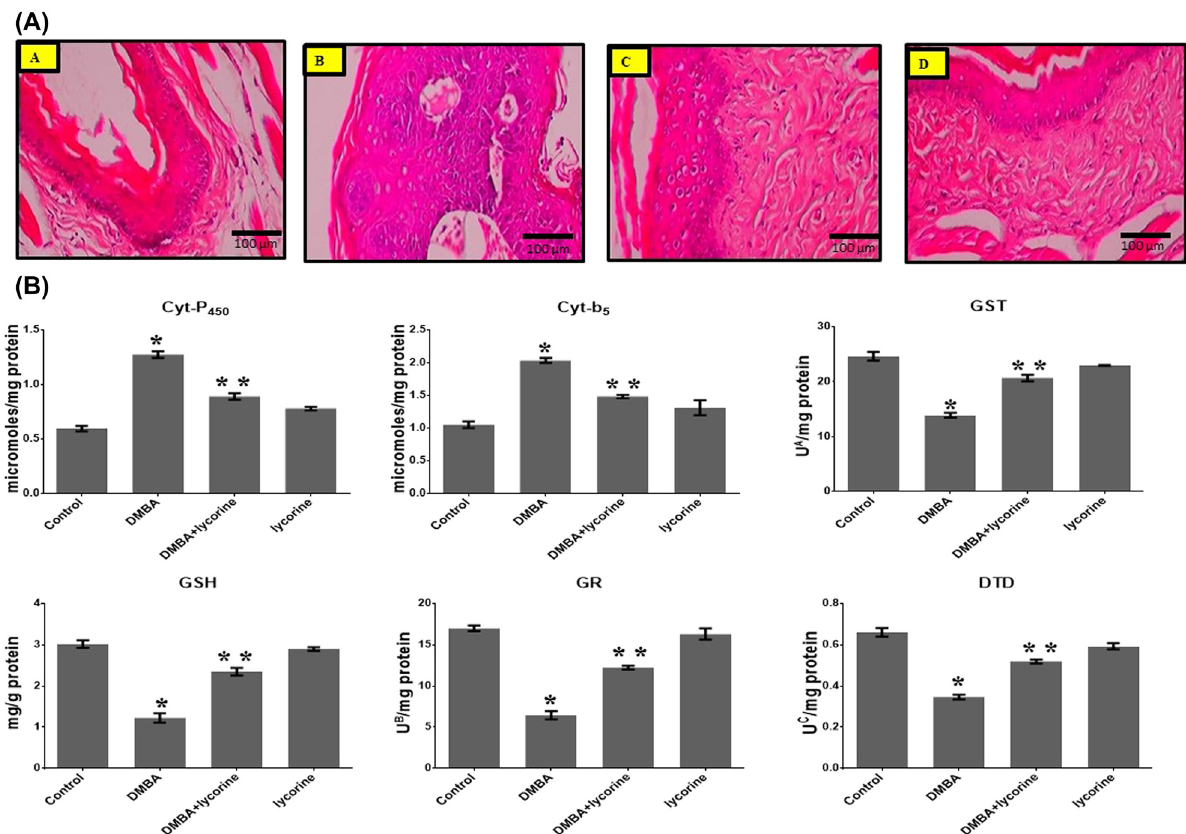
Figure 1: (A) Histopathological alterations in the buccal mucosa of all experimental hamsters. A and D images show distinct epithelium of buccal pouch in hamsters of normal control and lycorine-alone treated group. B images show well-differentiated squamous cell carcinoma DMBA alone treated animals.C images show very low or moderate dysplastic epithelium in hamsterstreated with DMBA and lycorine. Images are showed in 40 × magni fi cation. (B) Effect of lycorine on the activities of phase I and phase II detoxi fi cation enzymes in the liver of all experimental hamsters. A-Micromoles of CDNB/GST conjugate developed per minute. B-Micromoles of NADPH oxidized per